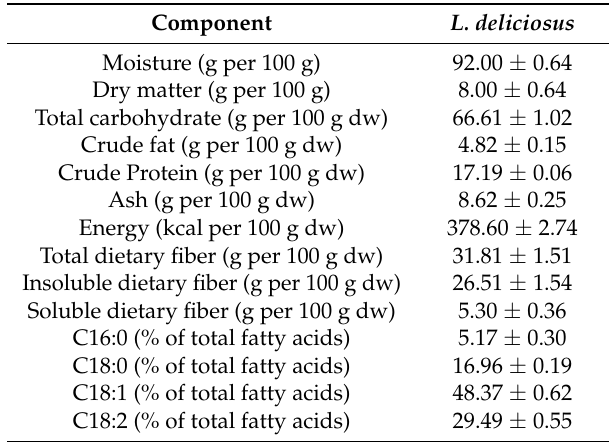
Table 1. Proximate composition, energetic value, dietary fiber, and fat composition of wild L. deliciosus